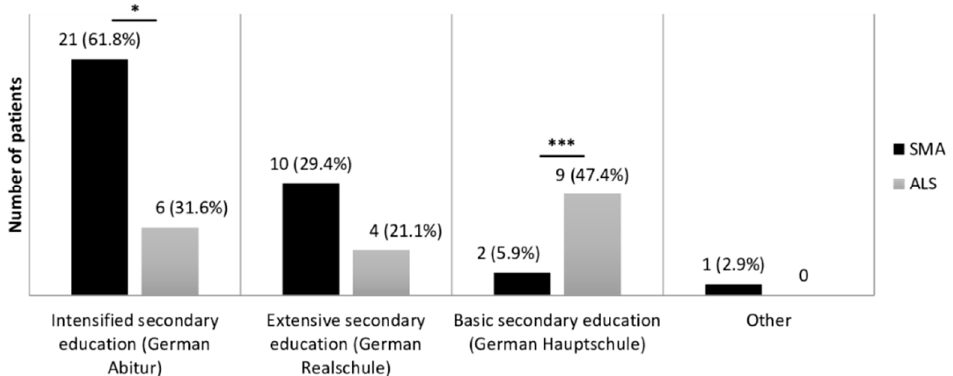
Figure 1. Comparison of education levels in SMA and ALS patients. Education levels, according to the German education system, were compared between SMA ( n = 34) and ALS ( n = 19) patients. Significance levels: * p ≤ 0.05, *** p ≤ 0.001. Abbreviations: SMA, Spinal Muscular Atrophy; ALS, Amyotrophic Lateral Sclerosis.